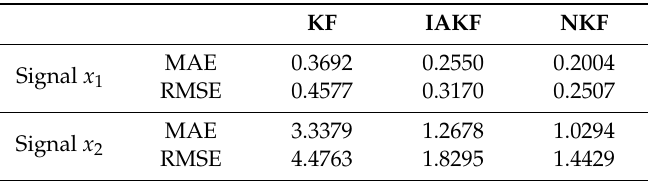
Table 1. Evaluation of filtering errors.